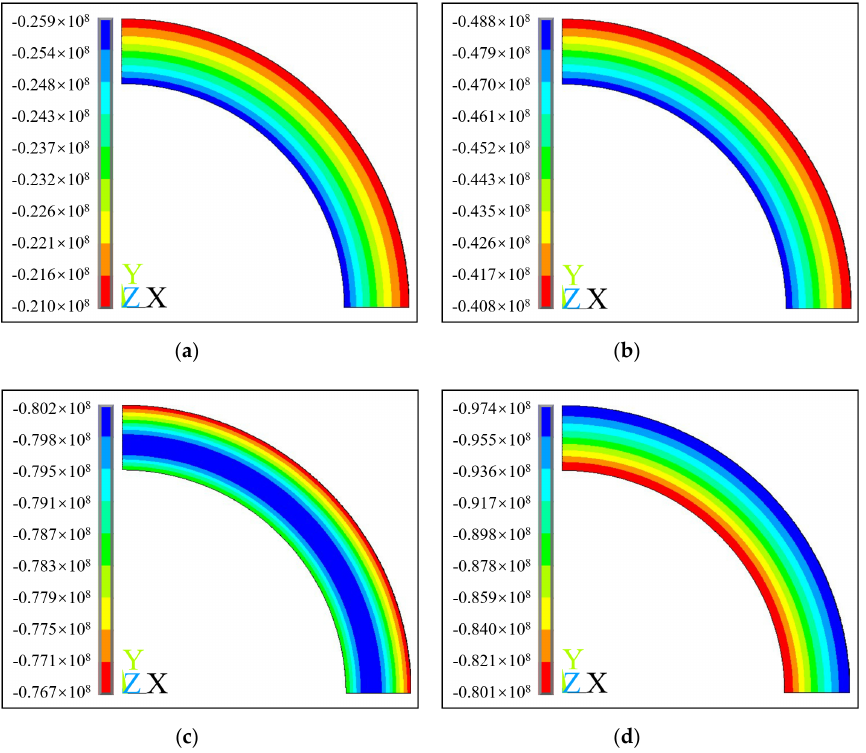
Figure 4. Hoop stress cloud diagrams of D-5 model shaft lining concrete under a surface load: ( a ) 5 MPa; ( b ) 10 MPa; ( c ) 18 MPa; ( d ) 23.3 MPa.